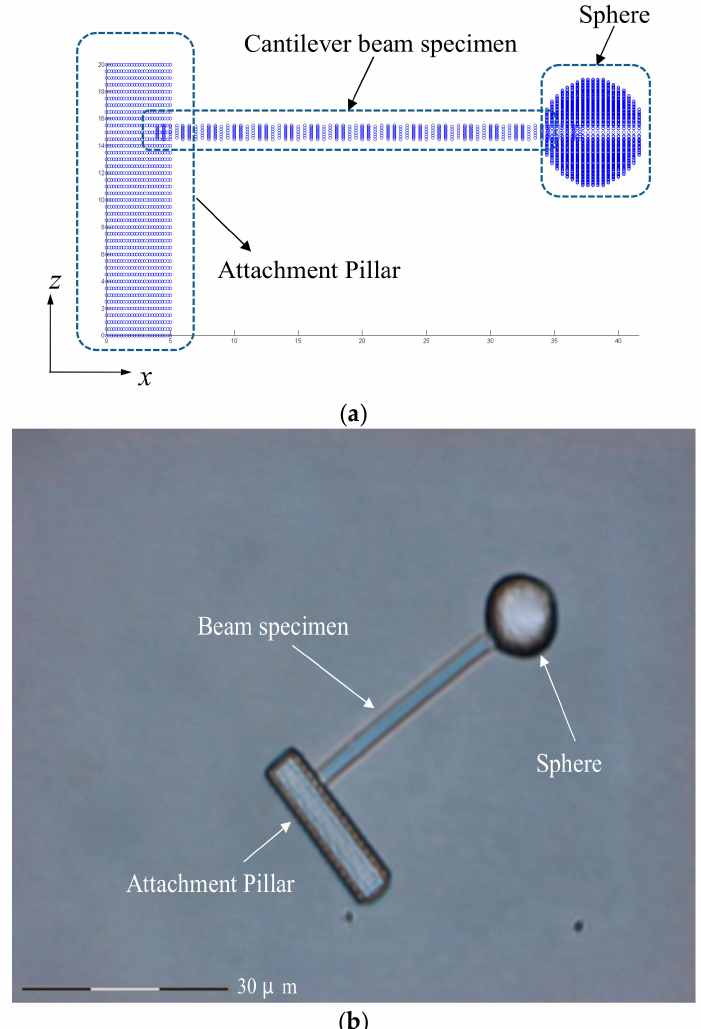
Figure 3. ( a ) The slicing scheme for TPP fabrication; ( b ) The image of a resulting specimen which has been made to fall flat on the cover slip through a purposely weakened foundation of the attachment